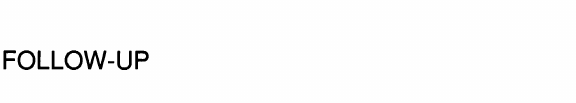
FIG. 4. Melodie's WISC-R profiles on the first evaluation and on the follow-up